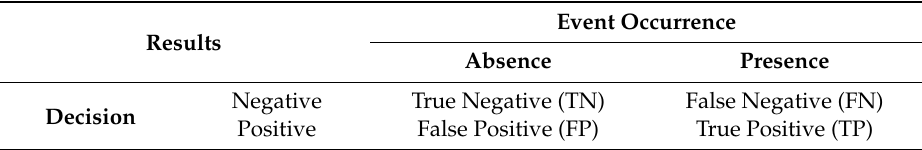
Table 5. Results classification.